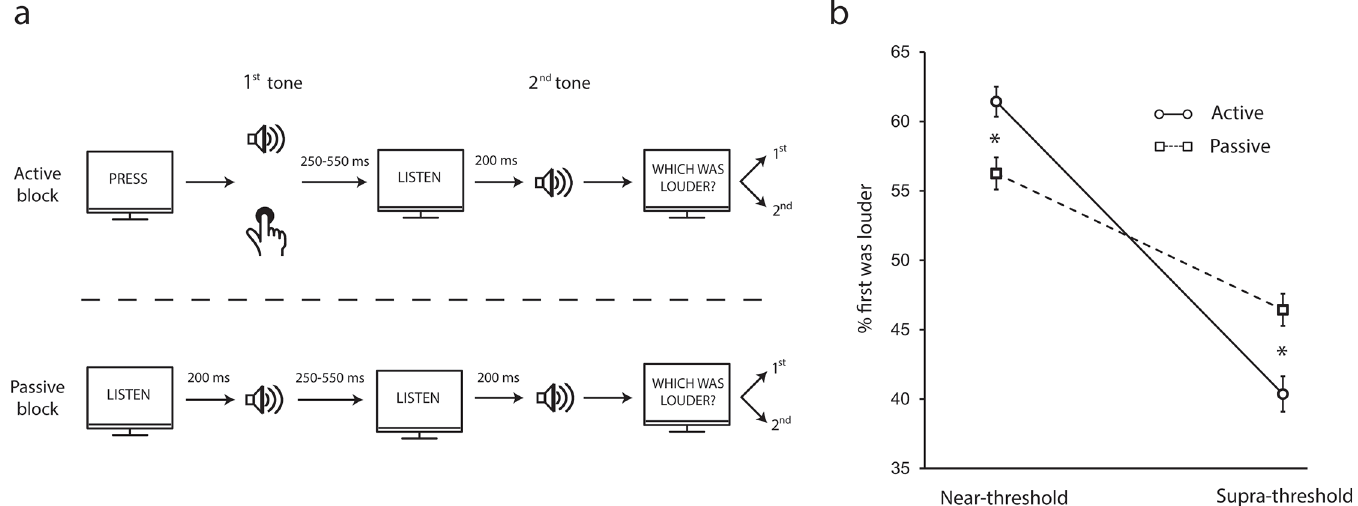
Fig 1. Experiment design and Results. (a) Subjects were presented with two tones and had to decide which tone was louder. In the active condition subjects triggered the first tone by a button press whereas the second tone was generated by a computer (top); in the passive condition, both tones were generated by a computer (bottom). (b) Mean % trials in which 1 st tone was reported being louder (error bars denote s.e.m. across 28 subjects). Perceived loudness of self-generated sounds is differently modified by the sound intensity (repeated measured ANOVA, p < 0.05). The asterisks denote significant differences between corresponding active and passive conditions within each sound intensity (p < 0.05 one-tailed paired